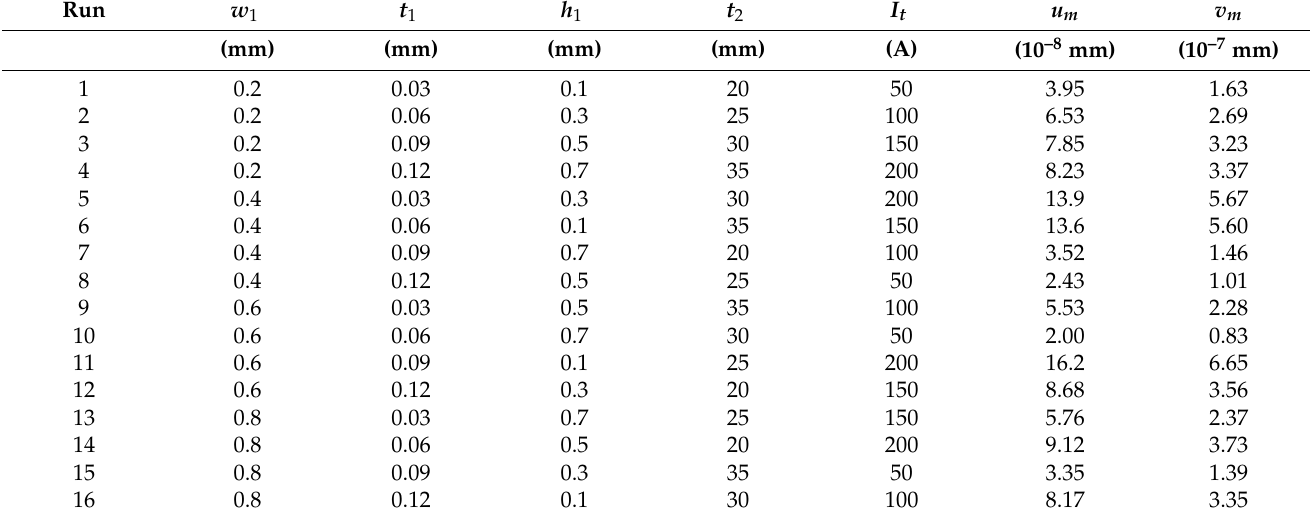
Table 3. Ranges of variation of EMAT